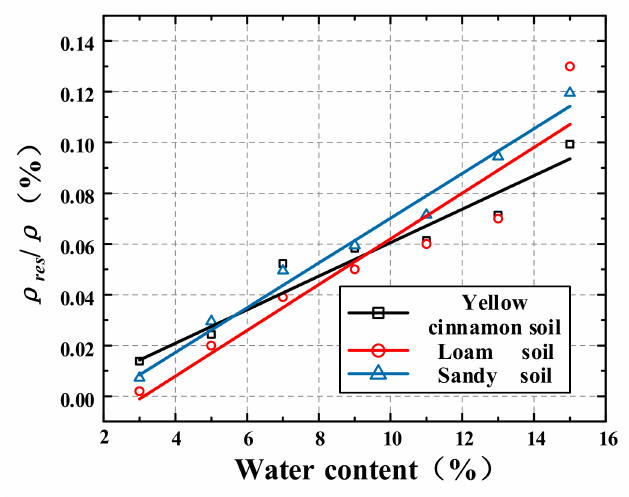
Figure 8. The influence of water content on ρ res under different soil types.